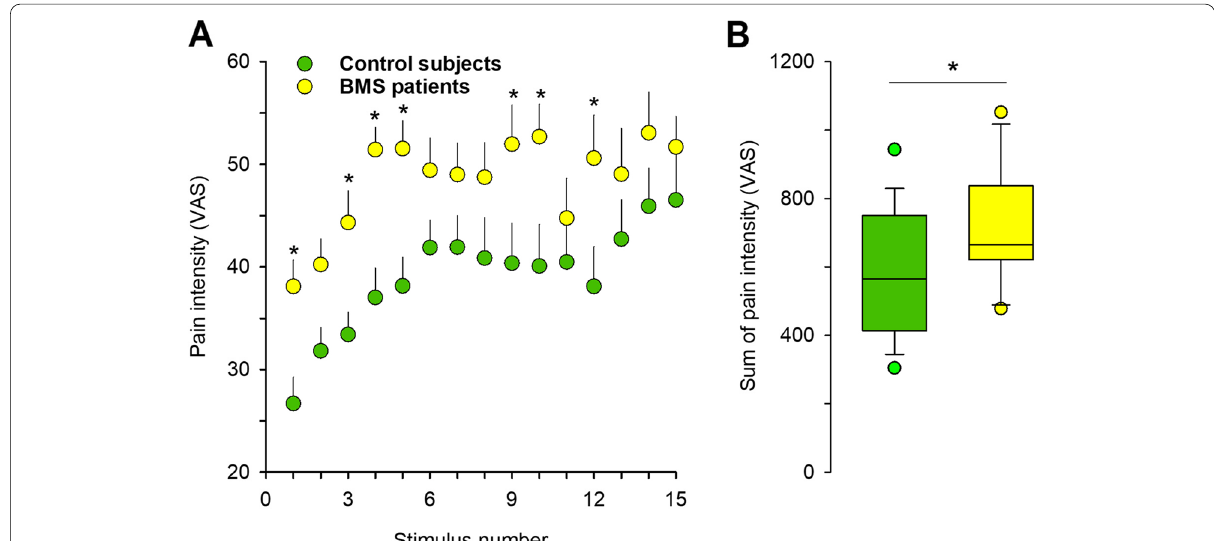
Fig. 1 Temporal summation of pain in burning mouth syndrome (BMS) patients and control subjects. A Time course of pain perception evoked by repetitive laser painful stimuli applied of the hand in control subjects, and BMS patients. Testing sessions consisted of a series of 15 blocks of 4 thermal test stimuli (Nd:YAP laser stimulator) that were delivered at 0.2 Hz on the back of the non‑dominant hand, repeated every 40 s for 10 min. Mean pain ratings ( SEM) are shown from the first to the 15th stimulation. *Linear mixed model: P ± time group. B Sum of pain intensity between 1 st ‑15 th . . * P value is from two‑tailed Student’s unpaired ×